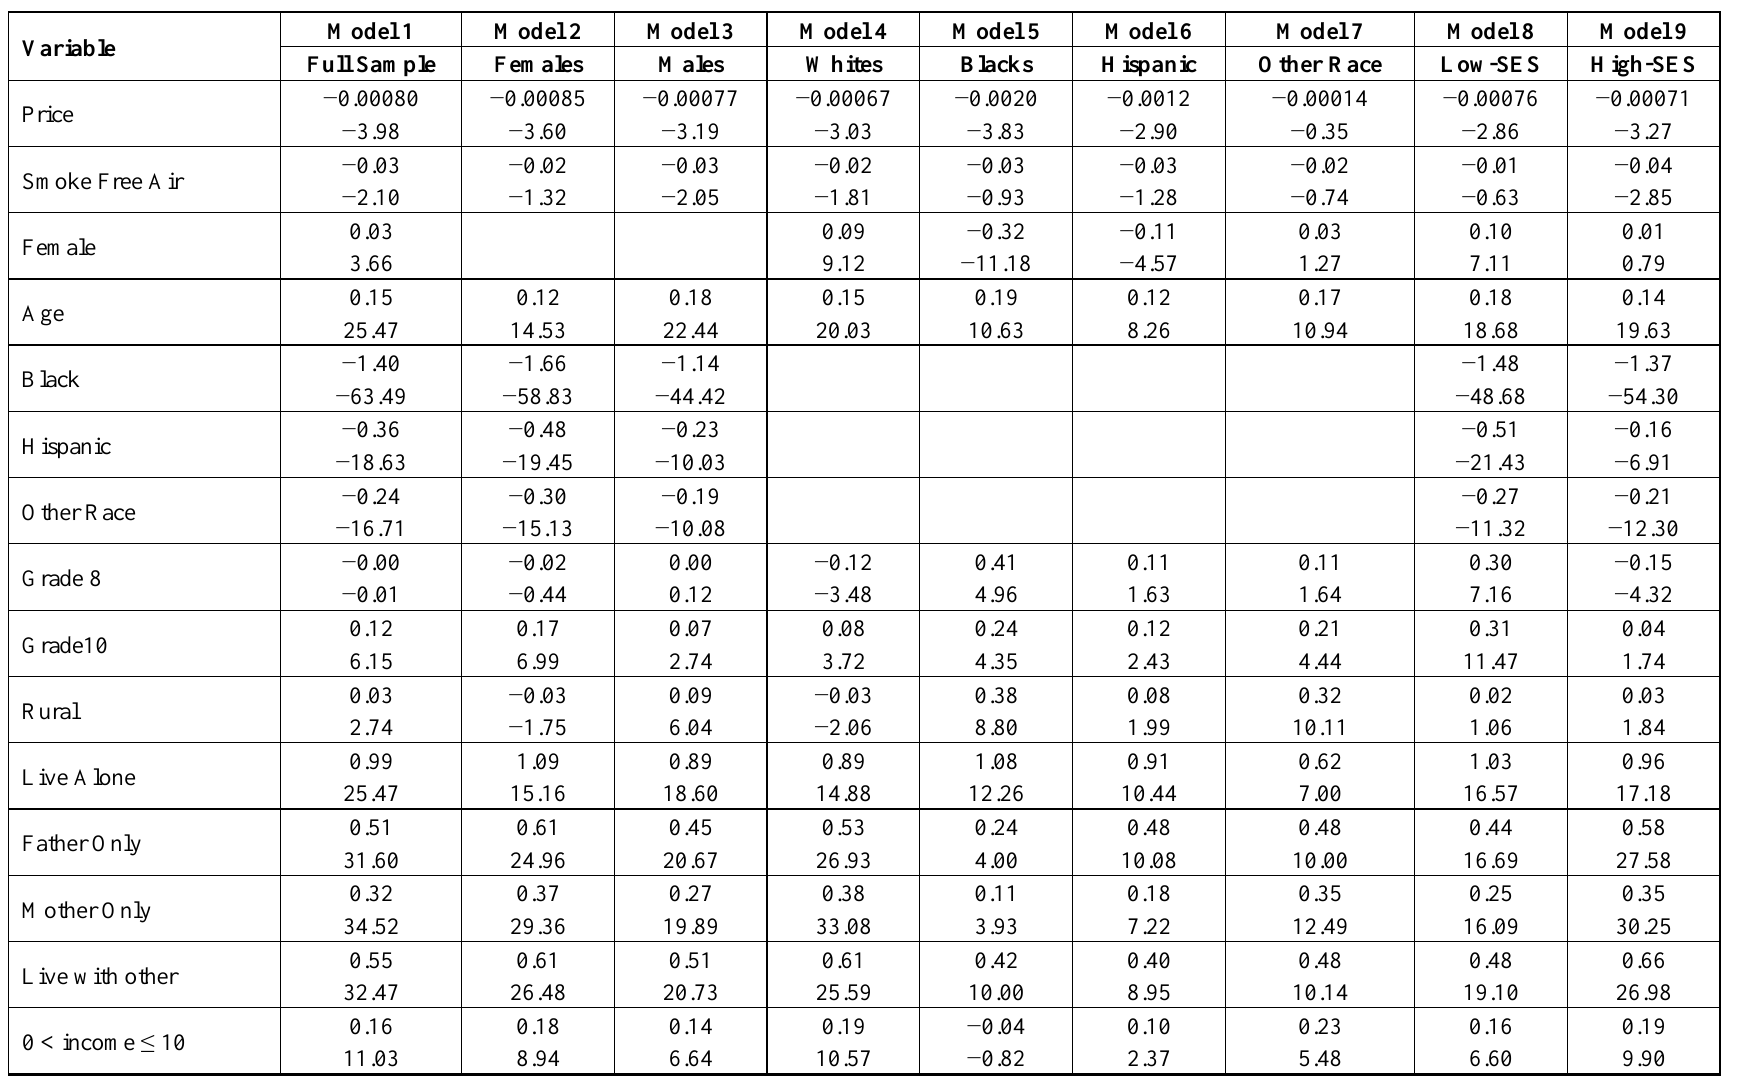
Table 2. Smoking Prevalence